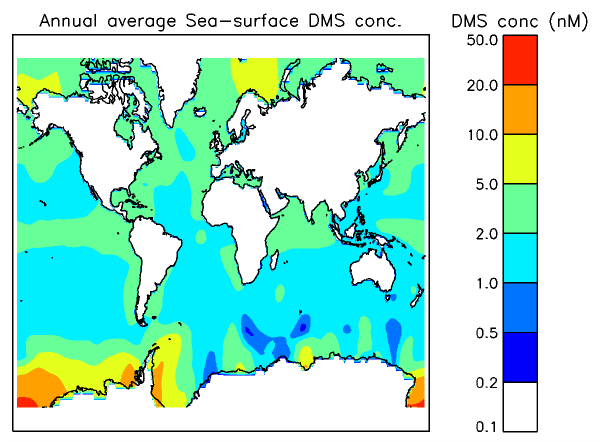
Fig. 1. Annual mean sea-surface DMS concentrations from the Ket- tle and Andreae (2000) observational